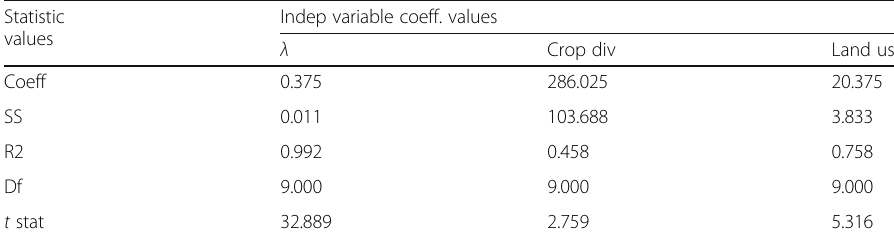
Table 5 Regression